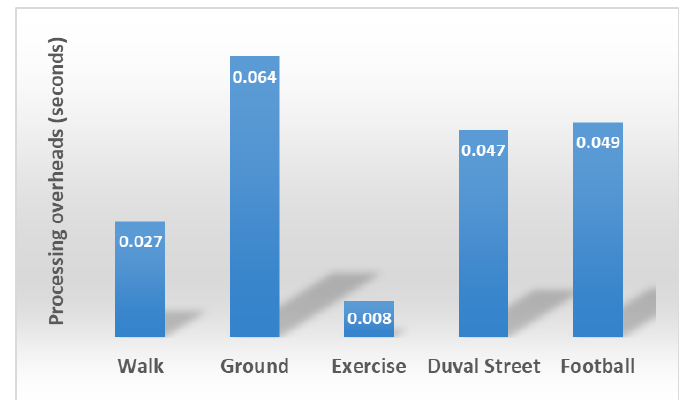
Figure 9. Average processing overhead at the sender for ROM